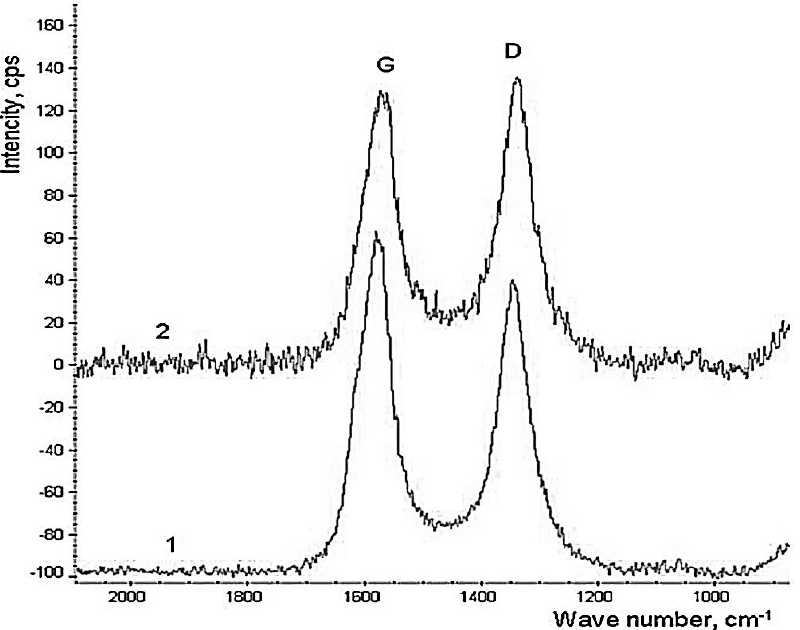
Figure 3. Raman spectra of (1) pristine MWCNTs and (2) APTES-treated MWCNTs.